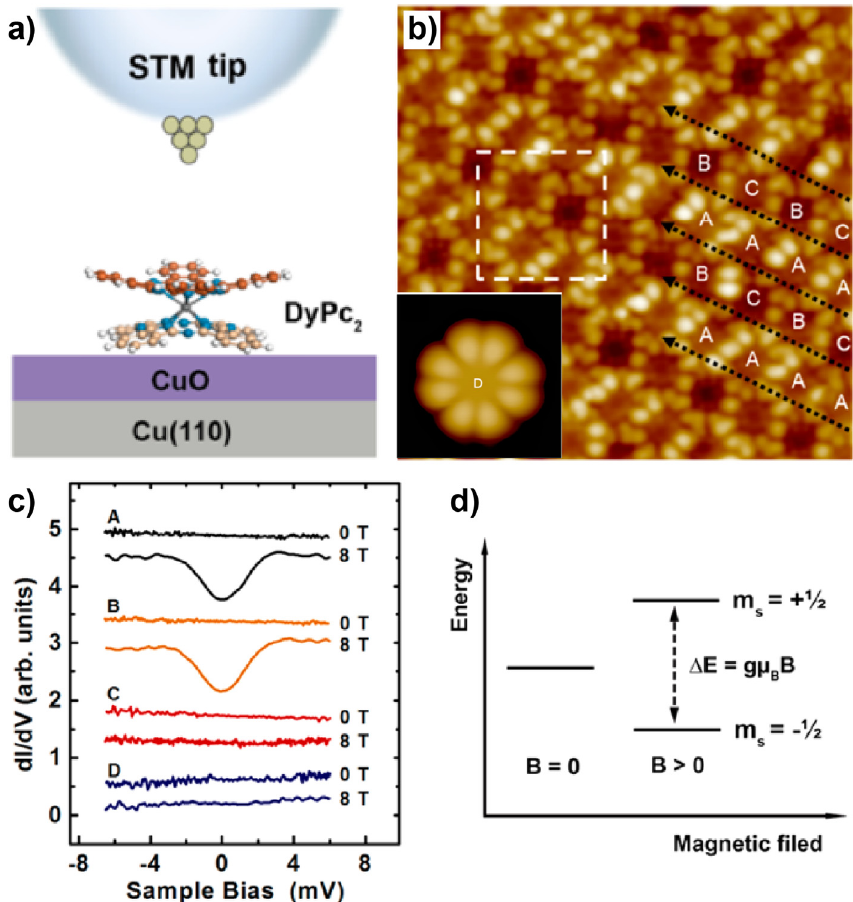
Figure 9. ( a ) Schematic illustration of the double-barrier tunneling junction (DBTJ) composed of STM tip, vacuum, DyPc 2 molecule, CuO film, and Cu(110) substrate. ( b ) STM image of the molecules A, B, and C in the assembled structure and the isolated molecule D (inset). ( c ) d I / d V spectra of molecules A, B, C, and D under magnetic fields of B = 0 T and 8 T. ( d ) Schematic showing the Zeeman splitting. Adapted from [93], with permission from American Chemical Society, 2018.